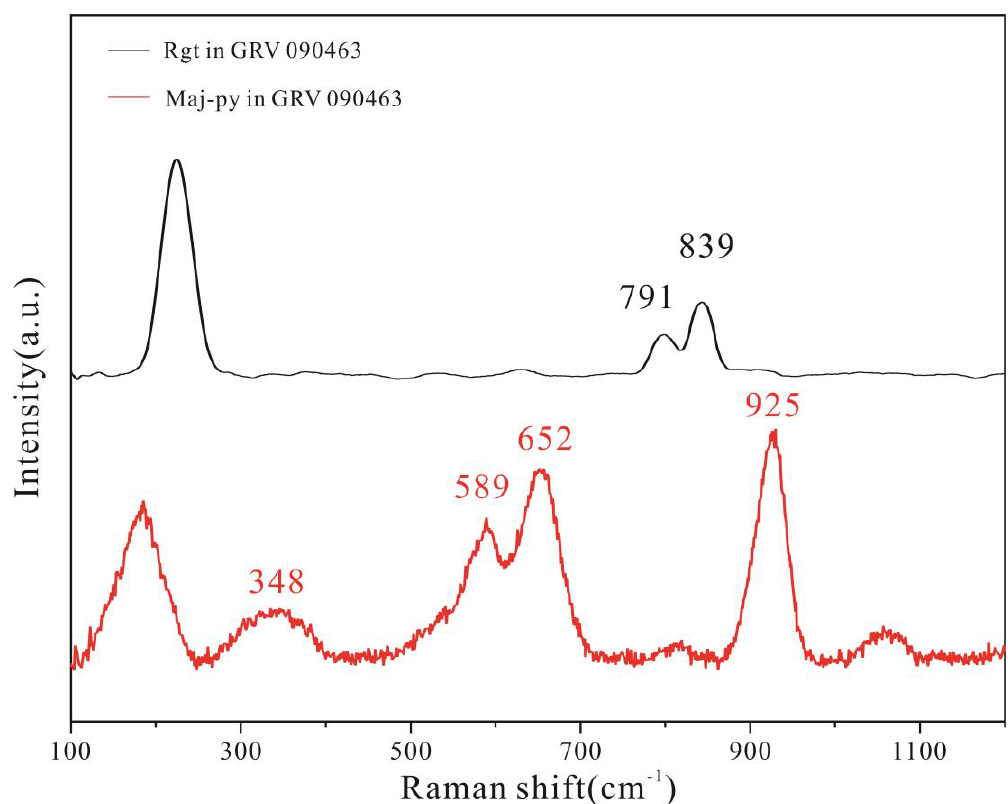
Figure 6. Raman spectra of ringwoodite (black) and majorite – pyrope (red) in GRV 090463.